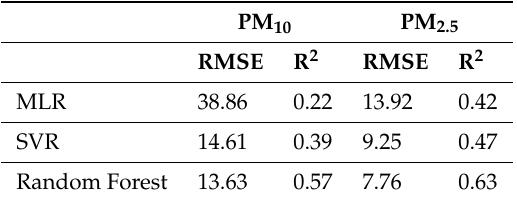
Table 4. Results of the prediction